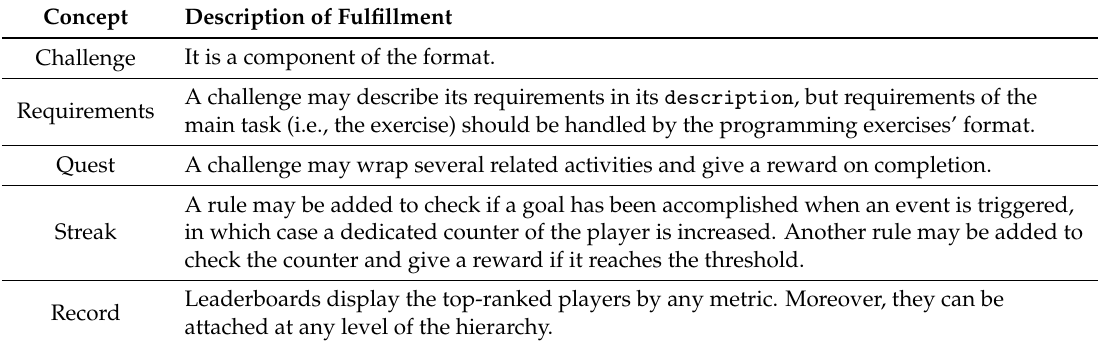
Table 2. Fulfillment of requirements from gamification concepts related to goals